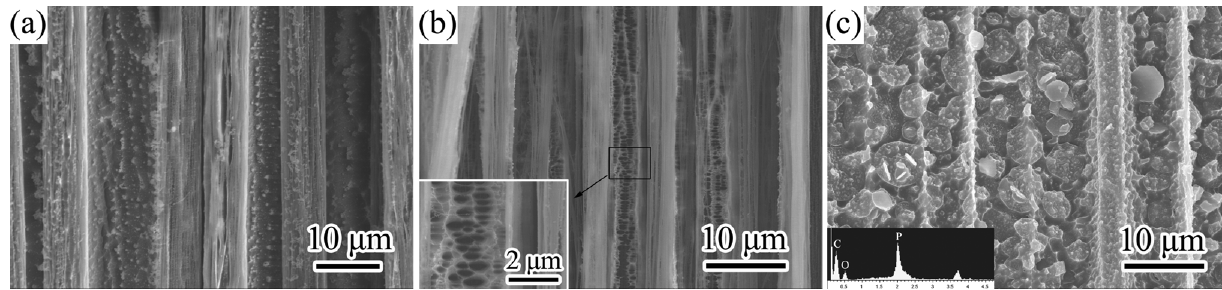
Figure 10. SEM images of mode I delamination surfaces after AO erosion of the ( a ) control, ( b ) PS0-C, ( c ) PS100-C. The mode I delamination surface of PS100-C after AO erosion is quite different.